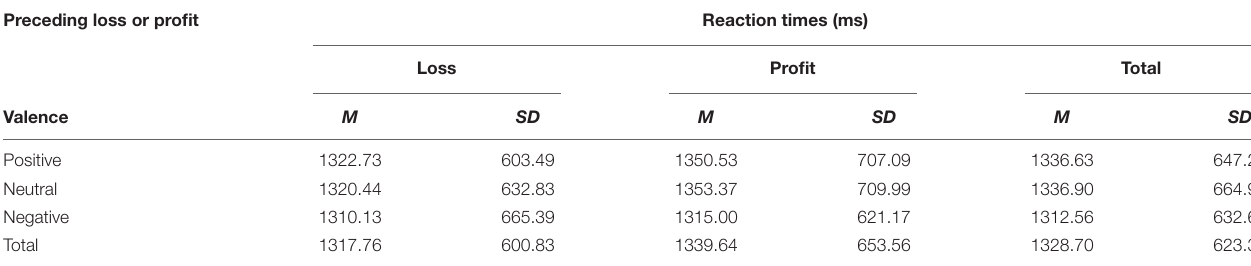
TABLE 3 | Means and standard deviations of reaction times according to experimental